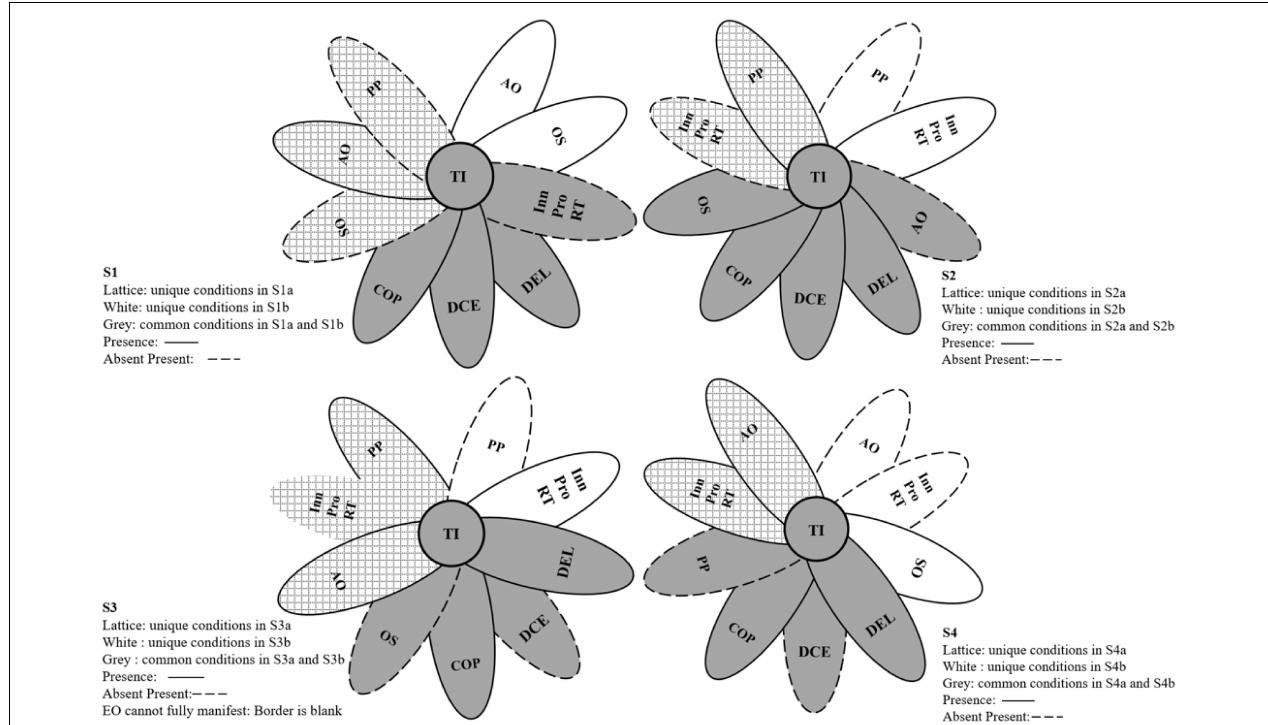
FIGURE 2 | Configurations for high middle management team innovativeness (fuzzy-set qualitative comparative analysis). CEO EO, CEO Entrepreneurship Orientation (including Innovativeness, Proactiveness, and Risk-taking); OS, Organisational Structure; COP, Confidence in the Organisation’s Prospects; AO, Achievement Orientation; PP, Performance Pressure; TI, Middle Management Team